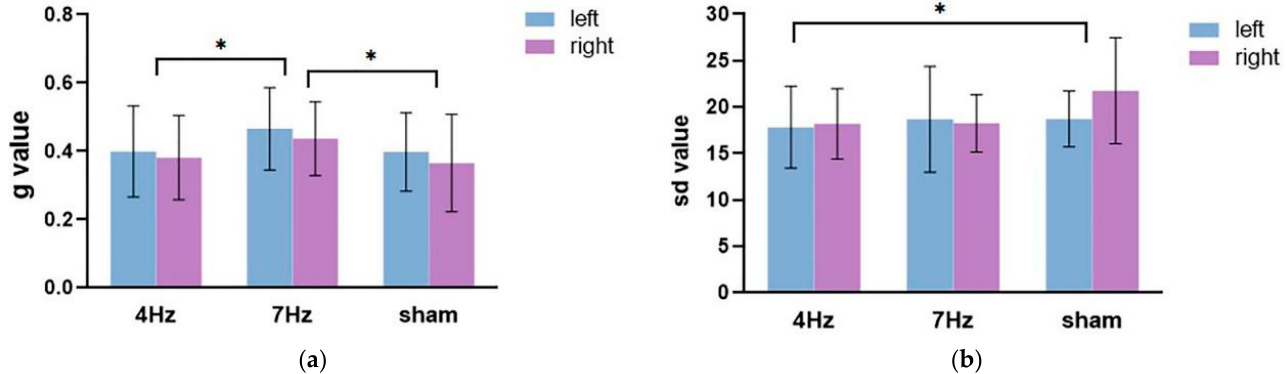
Figure 4. The results of the guess rate ( a ) and precision ( b ) in the three stimulation conditions (4 Hz/7 Hz/sham) for the high WMC group. The blue bar represents the left hemifield and the purple bar represents the right hemifield. Note that higher sd values imply a worse quality and higher g values mean a lower quantity of working memory. The asterisks (*) at the top of bar graph denote p < 0.05.